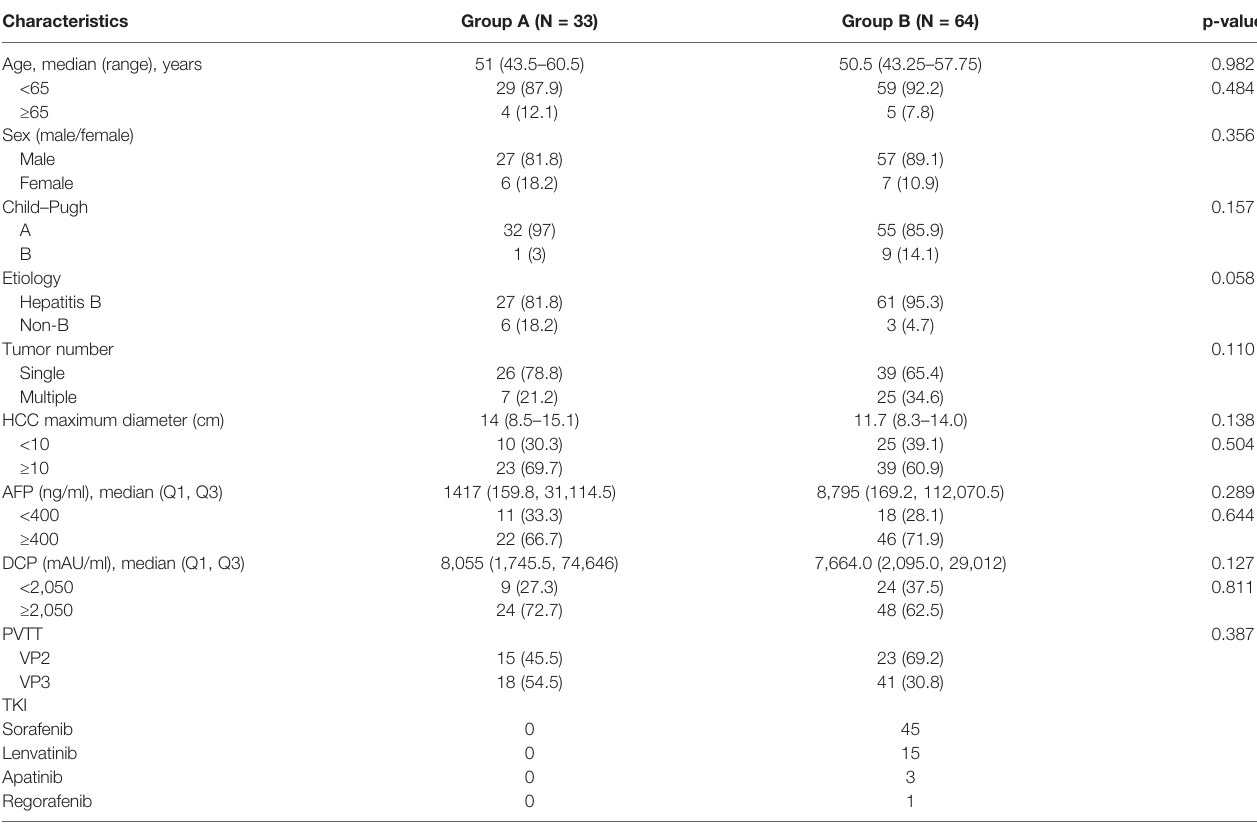
TABLE 1 | Baseline demographic and clinical characteristics of patients with large unresectable HCC with ipsilateral PVTT. Characteristics